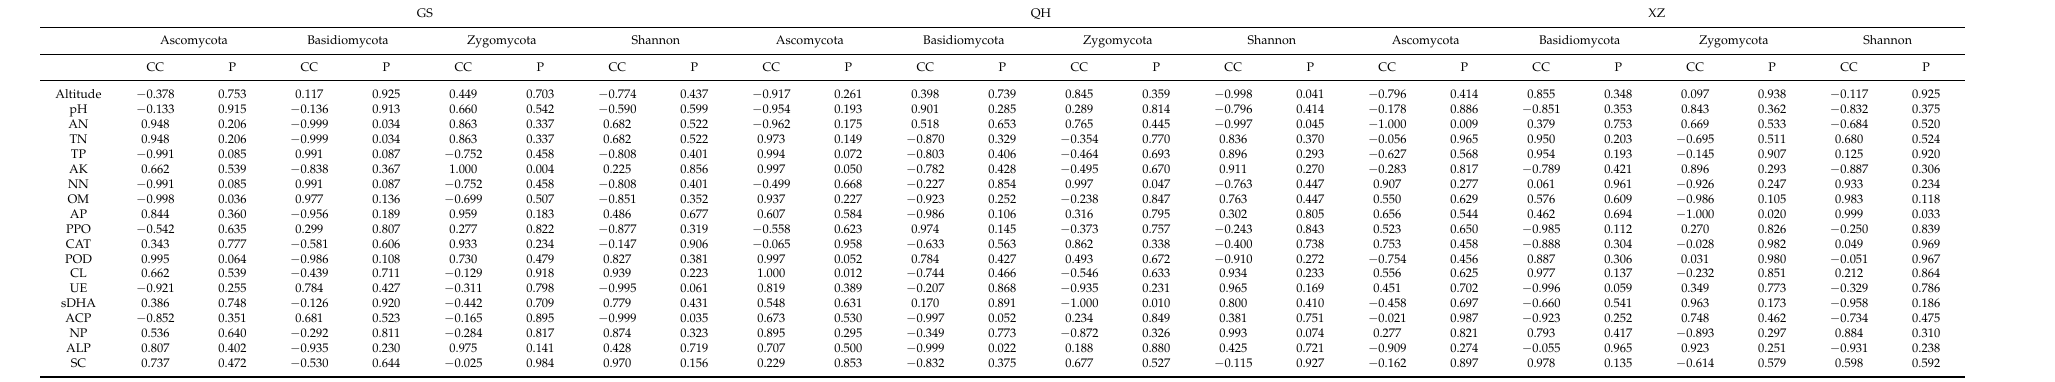
Table A1. Pearson correlation analysis of S. purpurea fungi community.